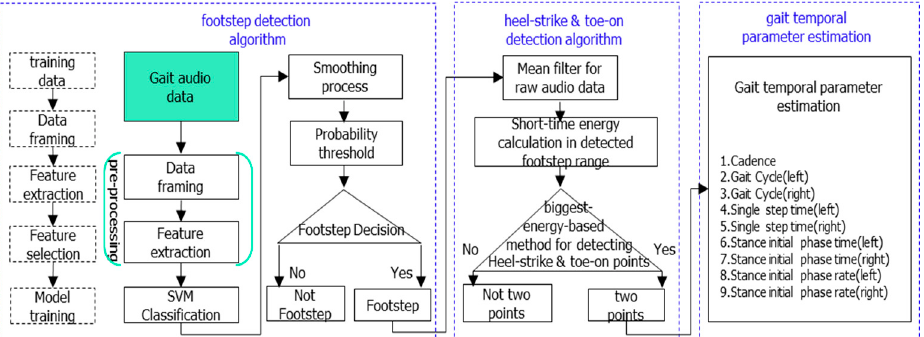
Figure 3. Flowchart of the temporal gait parameter estimation algorithm.